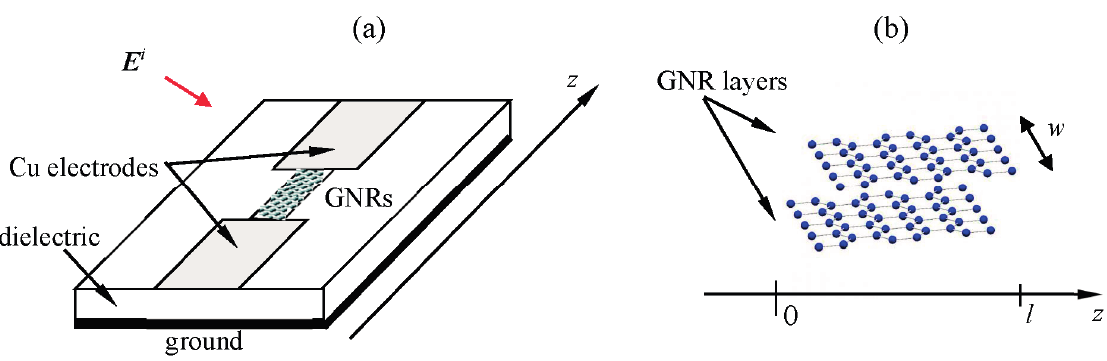
Figure 1. The proposed THz detector: ( a ) microstrip-like structure with a graphene contact; and ( b ) details of the few-layer graphene nanoribbons in the circuit